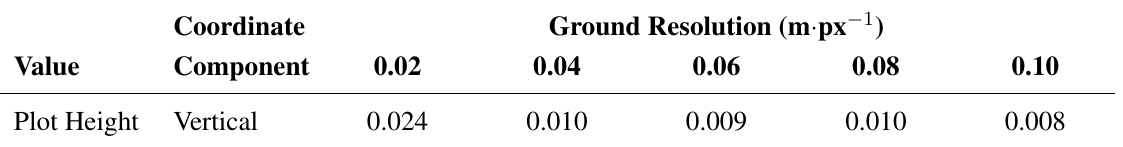
Table 4. Resulting root mean squared errors (m) (RMSE) of comparing mean plot heights calculated from indirectly (GCP-based) and directly (GNSS- and IMU-based) geo-referenced imagery at Z32 for all image ground resolutions. Coordinate Value Component 0.02 0.10 Plot Height Vertical 0.024 0.010 0.009 0.010